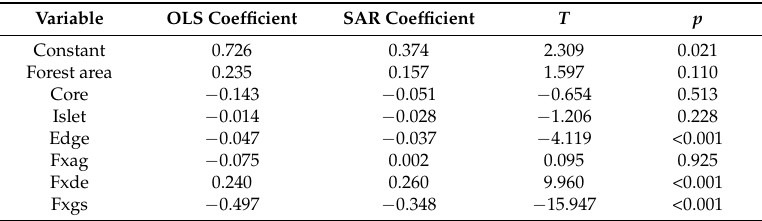
Table 1. Effects of forest fragmentation and edge types on pest richness across the forests in the conterminous United States based on the ordinary-least-squares (OLS) estimation and spatial autoregression analyses (SAR). Data were aggregated to the county level ( N = 2098) and were log-transformed before analysis. Forest edge types: Fxag = forest|agriculture, Fxde = forest|developed, and Fxgs = forest|grass-shrub.